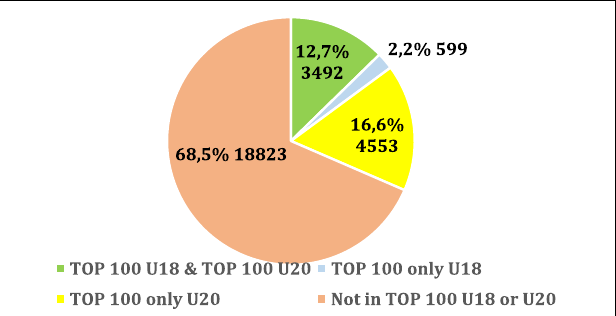
FIGURE 1 | Performance of U18 and U20 athletes who were ranked in the top-100 as